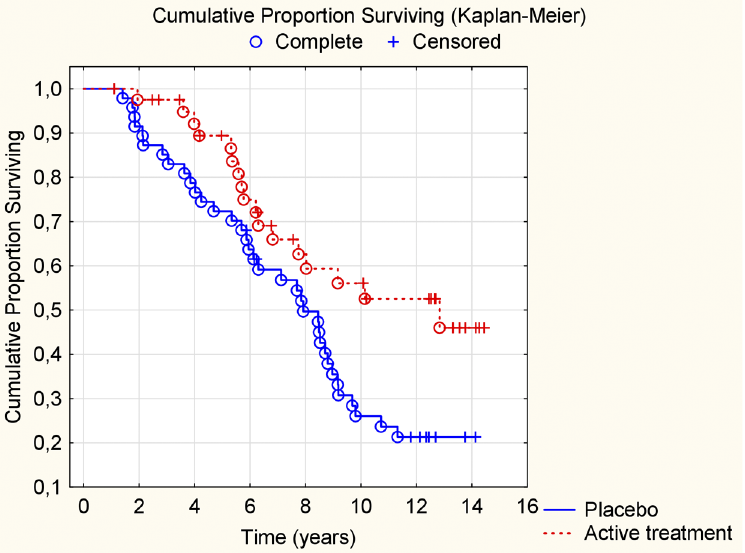
Fig 6. Kaplan-Meier graph illustrating cardiovascular mortality in participants with NYHA functional class III during a follow-up period of 12 years of those supplemented with selenium and coenzyme Q10 versus placebo for four years on top of regular pharmaceutical